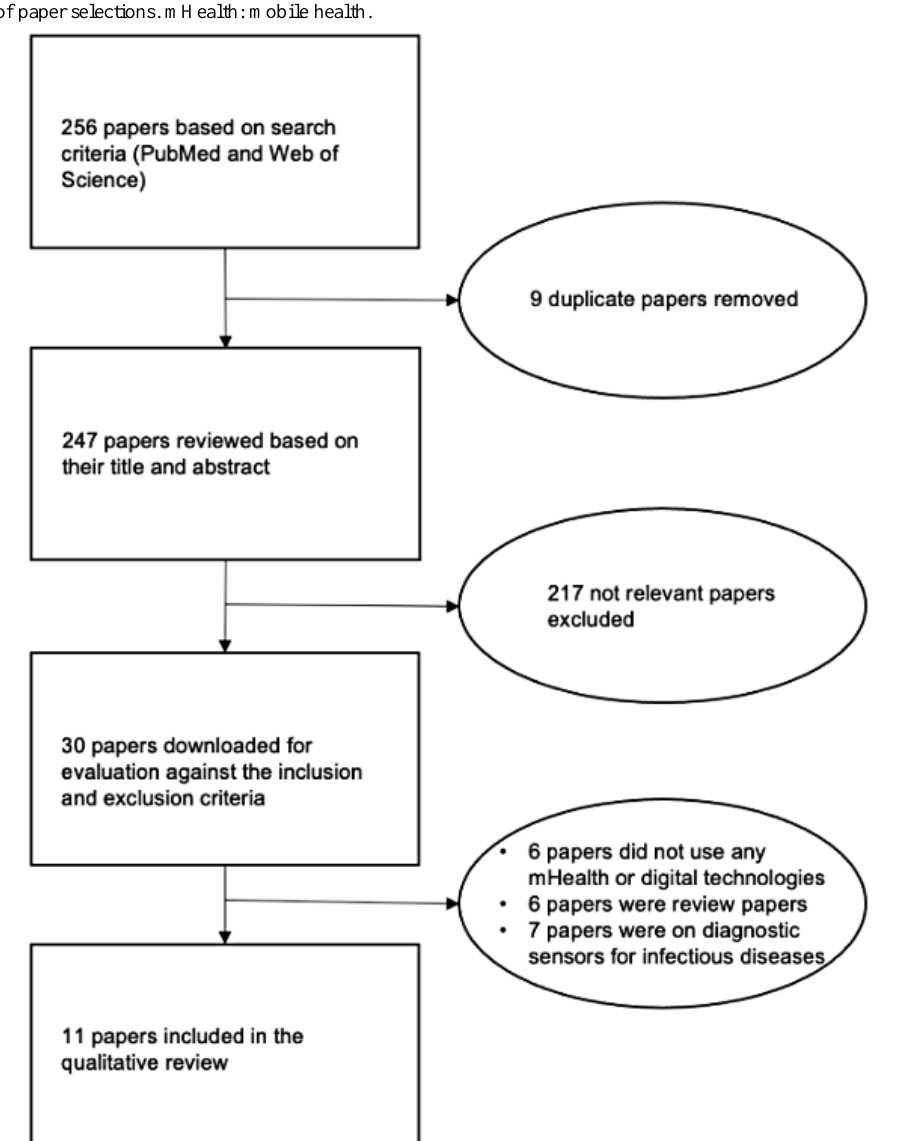
Figure 2. Flowchart of paper selections. mHealth: mobile